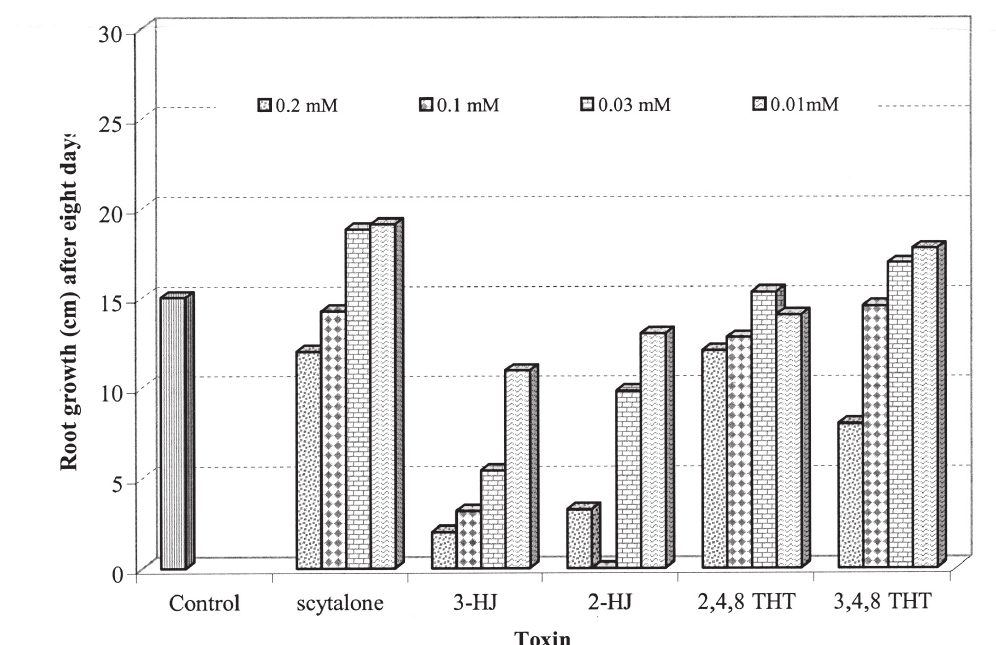
Fig. 4. Arabidopsis thaliana root growth after 8 days of incubation in the presence of various toxins at four different concentrations. (2HJ at 0.1 mM was